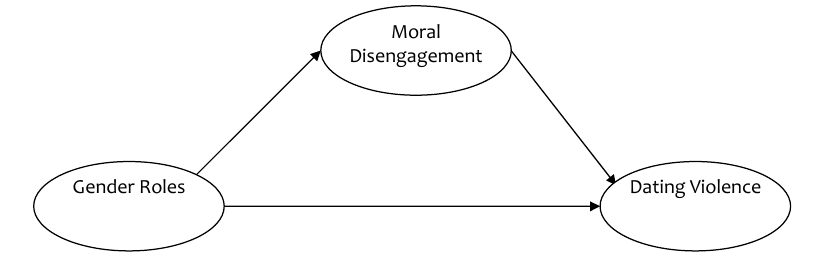
Figure 1 . The hypothesized structural